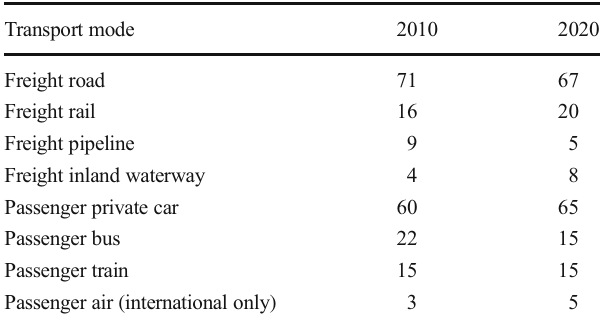
Modal split (ton km % and passenger km %) in Hungary in 2010 and in 2020